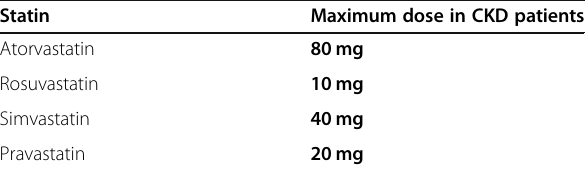
Table 3 Statin doses in CKD patients Statin Maximum dose in CKD patients Atorvastatin 80 mg